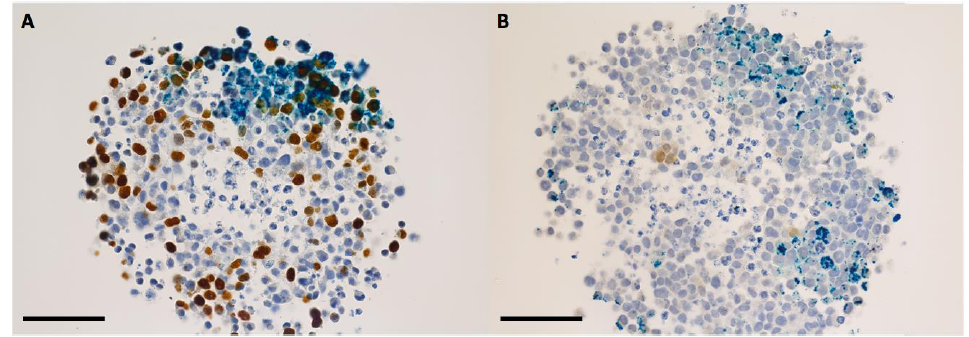
Figure 6. Bright-field microscopy images — details of HeLa spheroid sections that were previously incubated for 48 h with 200 μg/ mL IONP DOX ; immunohistochemical staining of proliferative areas using bromodeoxyuridine ( A ), and of hypoxic areas using pimonidazol ( B ); light blue hematoxylin, dark blue IONP, dark brown proliferative cells, light brown hypoxic cells; measure bar is 50 μ m.